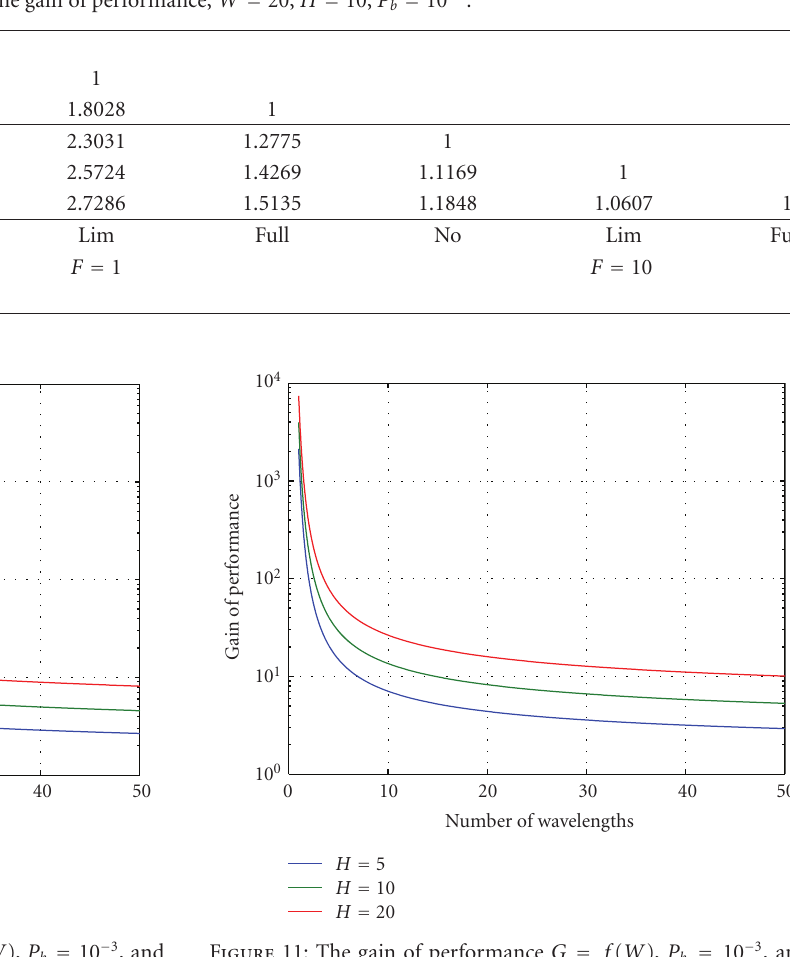
Table 4: The gain of performance, W = 20, H = 10, P b = 10 − 3 .